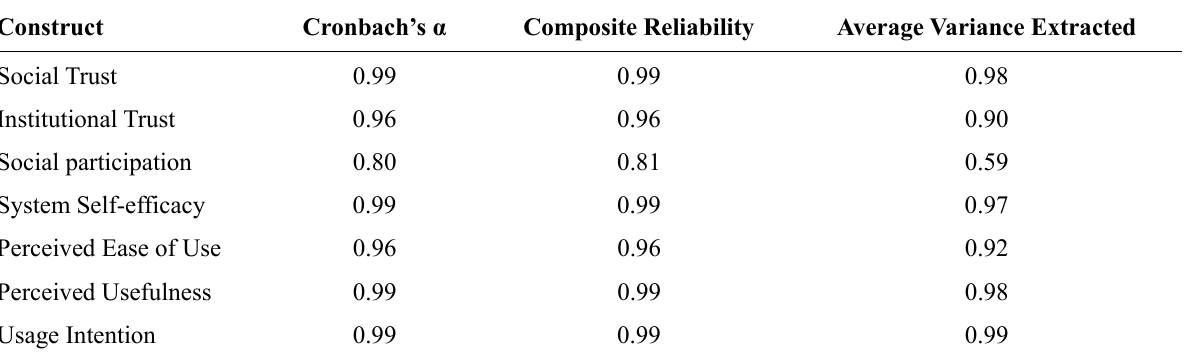
Table 2. Construct Reliability and Convergent